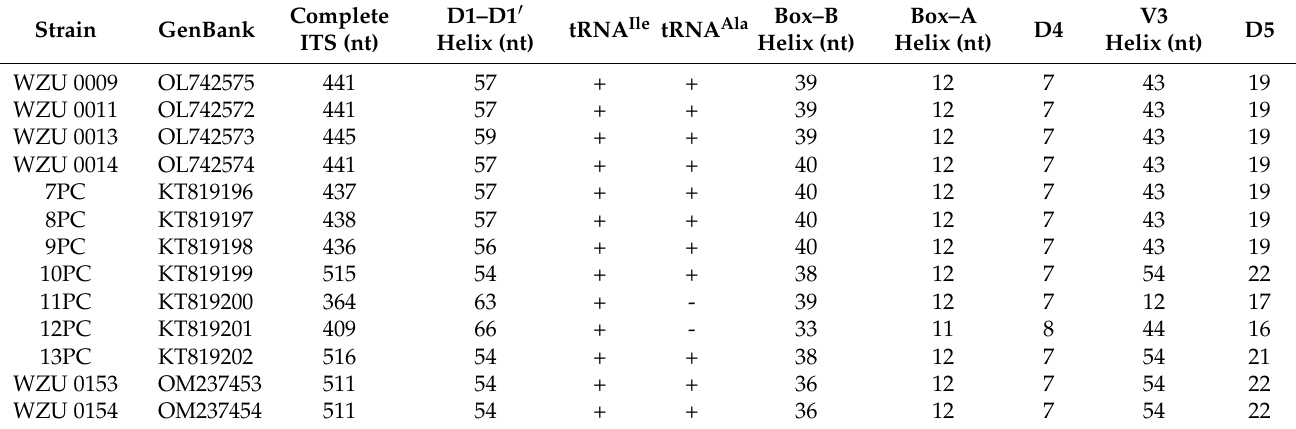
Table 2. Analyses on ITS of 16S–23S region for Ancylothrix strains.